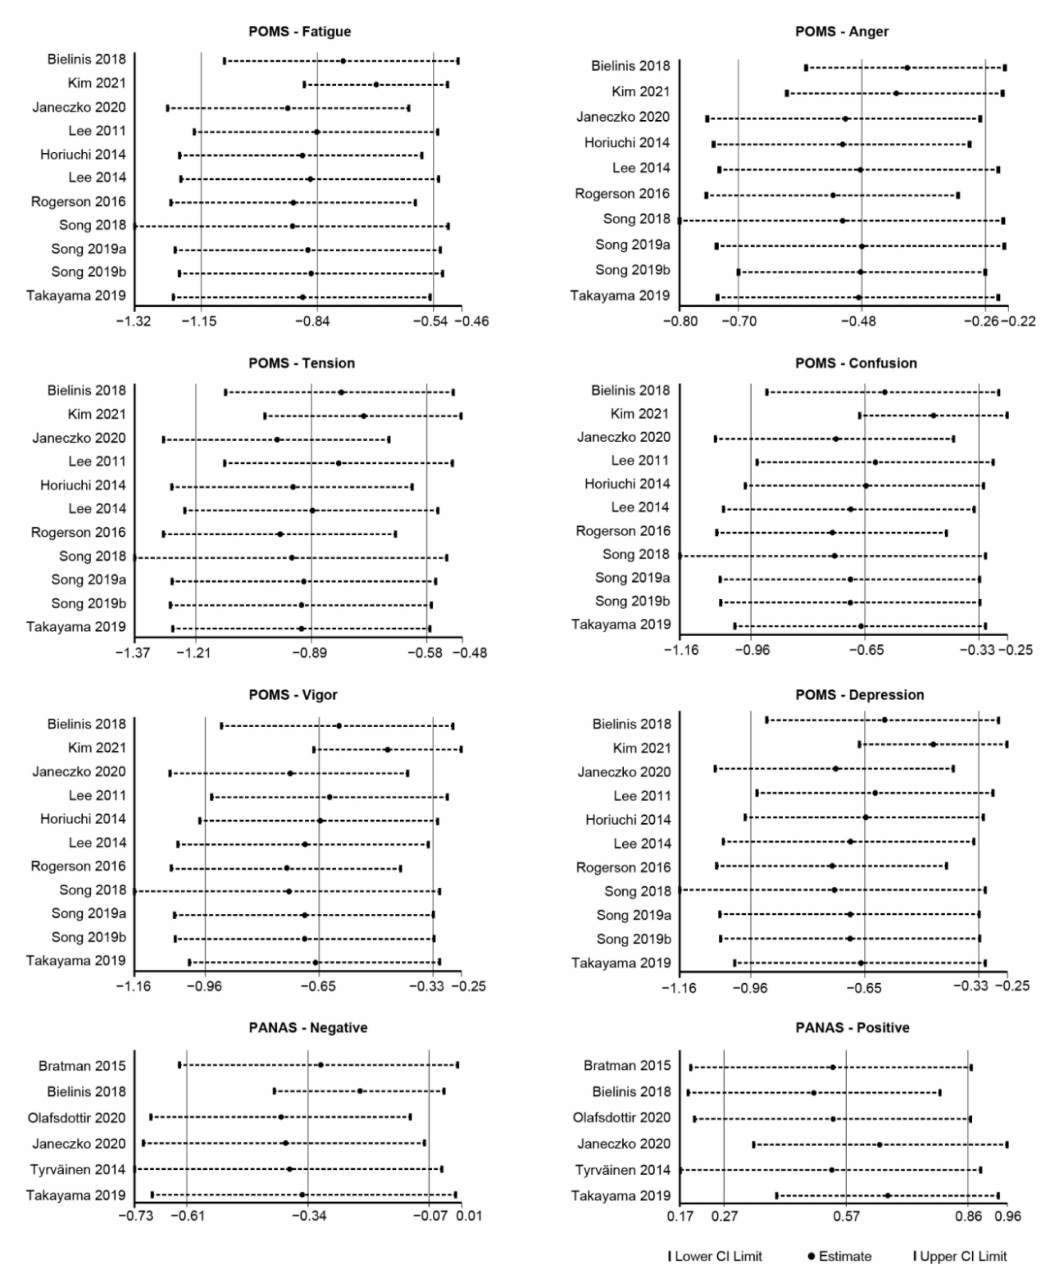
Figure 5. Overall sensitivity analysis of psychological outcome variables. Note. A sensitivity analysis was performed by leaving out one study item at a time and comparing the change in the pooled effect sizes before and after each item was taken out. After excluding each study, there were no significant changes in effect sizes or confidence intervals, indicating that the analysis results were relatively stable. POMS: Profile of Mood States; PANAS: Positive and Negative; CI = Confidence Interval